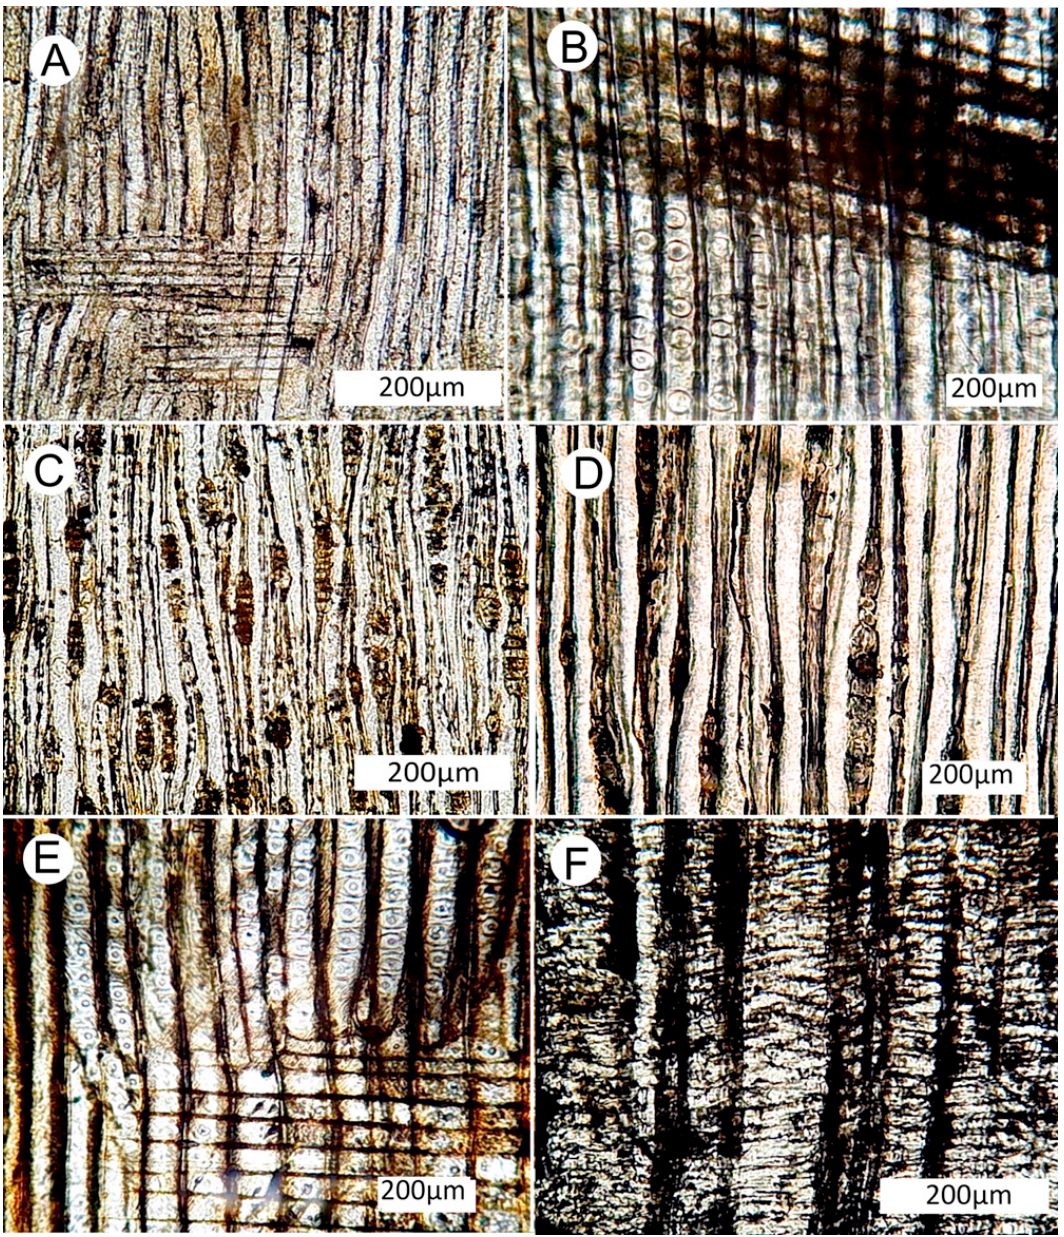
Figure 13. Cell anatomy.All specimens are from gymnosperms. ( A ) Specimen LC-B, radial view showing horizontal ray cells. ( B ) Specimen LC-B-radial view showing bordered pits typical of gymnosperms. ( C ) Specimen LC-C, tangential orientation revealing cross-section views of ray cells. ( D ) Specimen LC-D, tangential view showing ray cell cross-sections. ( E ) Specimen LC-E, radial view displaying horizontal ray cells and vertical tracheid cells containing uniseriate bordered pits. ( F ) Specimen LC-C, radial view showing ray cells as vertical lines and horizontal